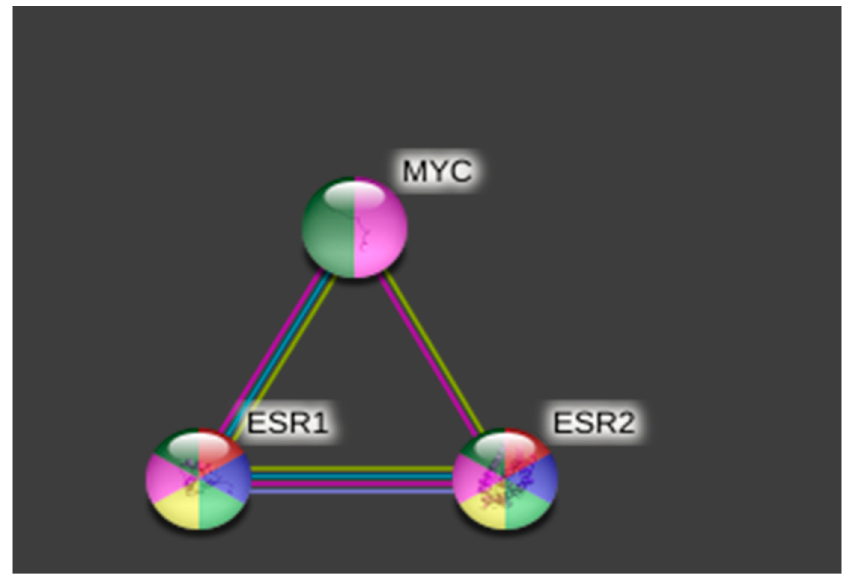
Figure 12. (A) Overall result of all models generated by HDOCK server ( B ) Binding of ER bound estradiol with c-myc gene 67 kb upstream of the promotor region at lowest energy score of − 229 kcal/mol (Model 2 at HDOCK) binding with LG score 5.606 and MaxSub < 0.8. ( C ) estradiol inter- acts with c-myc protein results available for job 60 ce3ba192bf6.